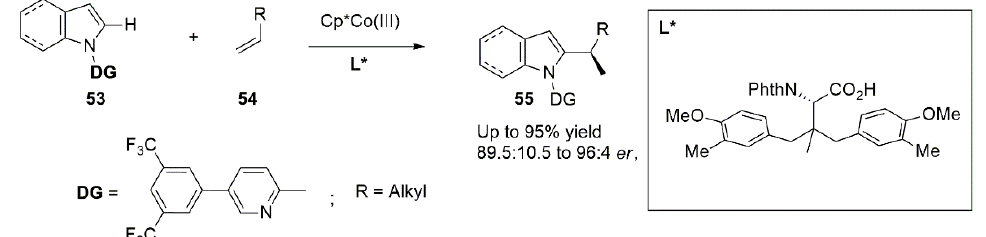
Figure 27. Use of amino acid-based bulky chiral carboxylic acid ligand (L*) for the synthesis of chiral C2-alkylated indoles ( 55 ).